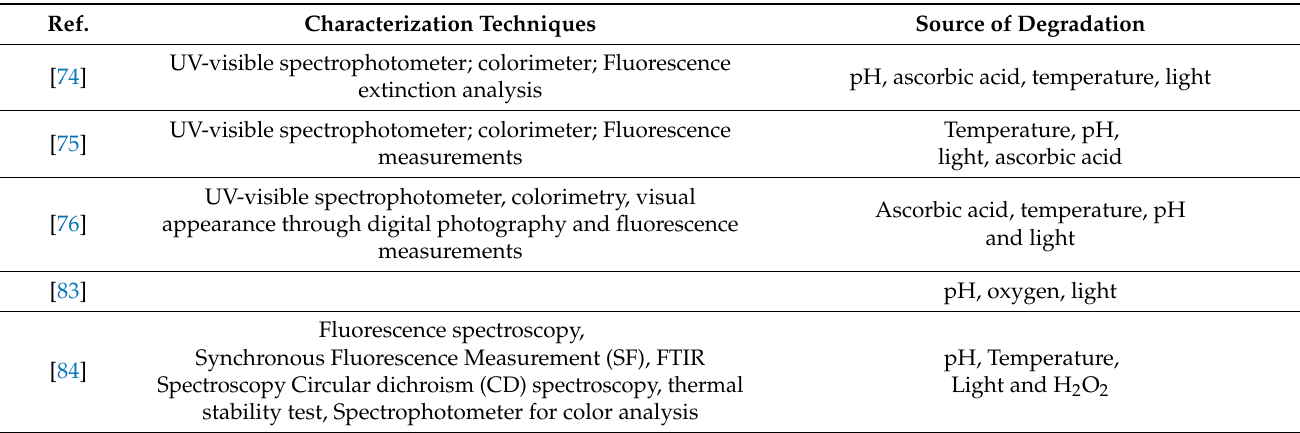
Table 4. Summary of characterization methods and stability mechanisms.